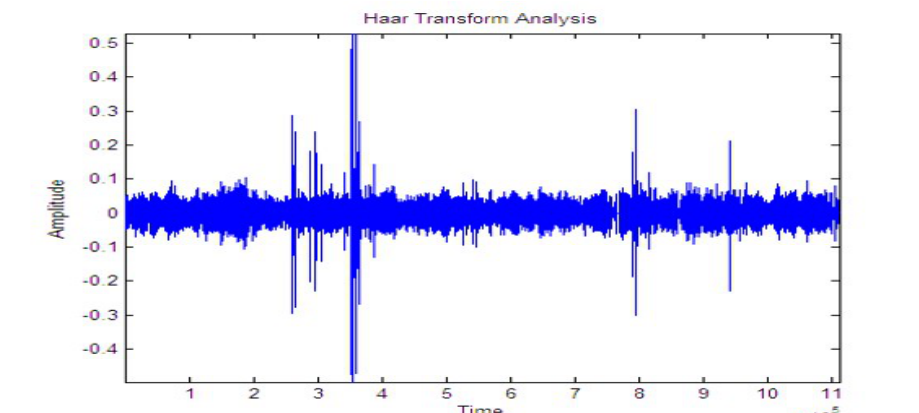
Figure 10. Signal while walking.